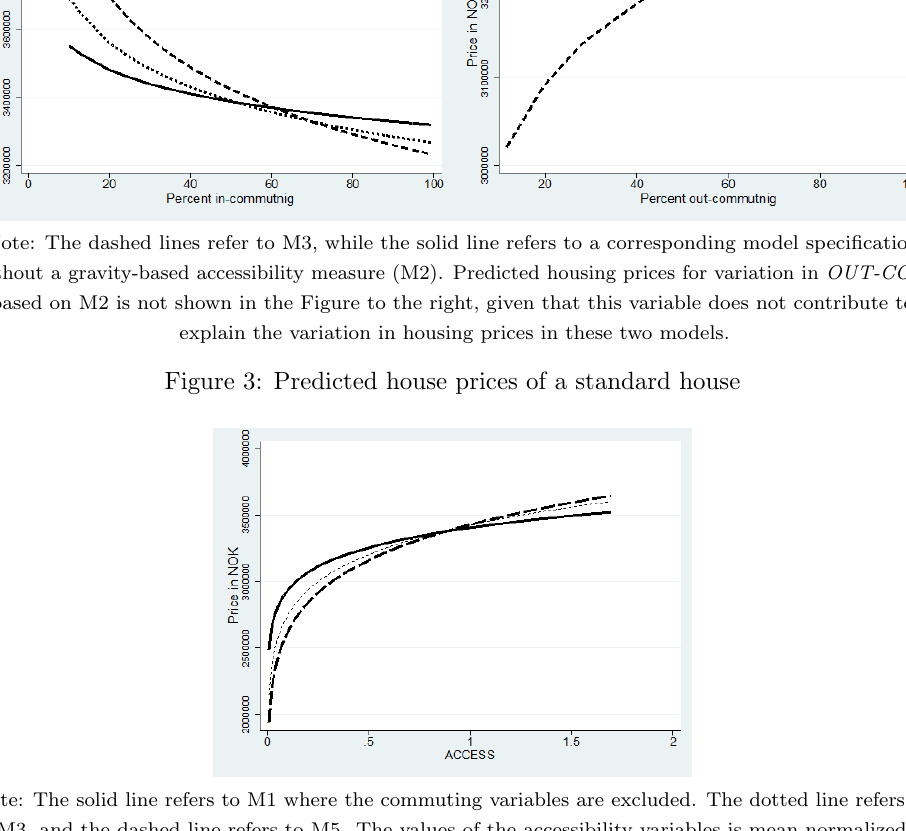
Figure 4: Predicted house prices of a standard